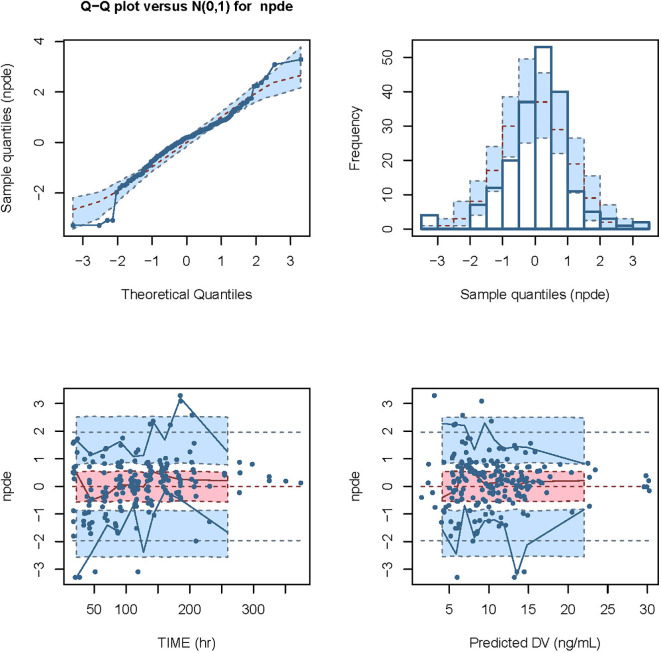
Modeling diagnosis and evaluation with NPDE analysis. The mean bias (± SE) of normalized prediction distribution errors (NPDE) was 0.09309 (± 0.071), variance (± SE) was 0.9898 (± 0.1), skewness was -0.3718, and kurtosis was 2.013. The statistical values of t-test and Fisher variance test were 0.193 and 0.947, respectively. The result of Shapiro-Wilk (SW) test for normality was 2.49 × 10-5, and the global adjusted p-value was 7.48 × 10-5.